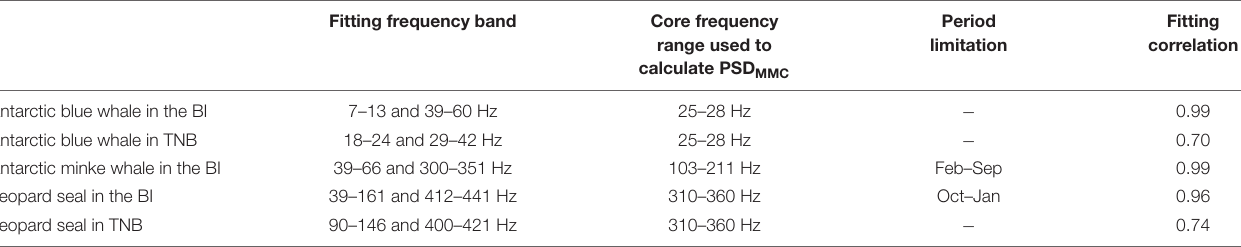
TABLE 2 | Spectral ranges used to calculate PSD MMC . We generally follow the methods adopted by Menze et al. (2017).